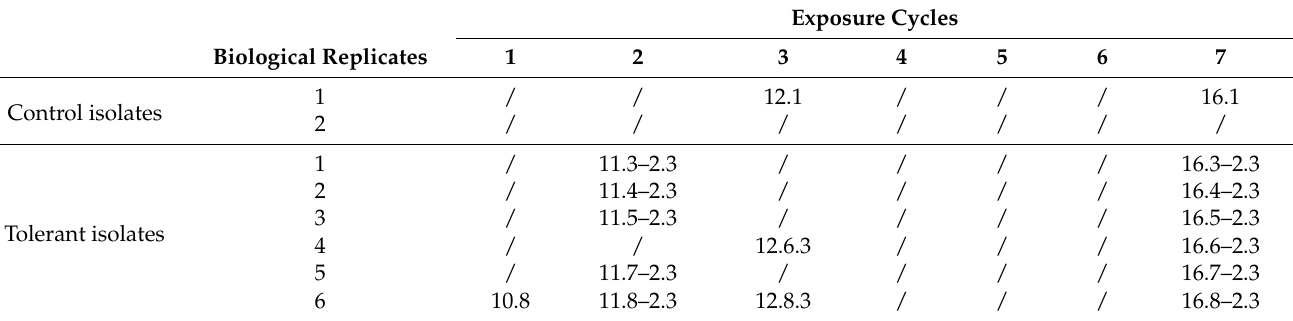
Table 1. Evolution of ceftriaxone tolerance over time (cycles 1, 2.7). The isolates that were subjected to whole-genome sequencing are colored in grey and the numbers denote the isolate identification (id).